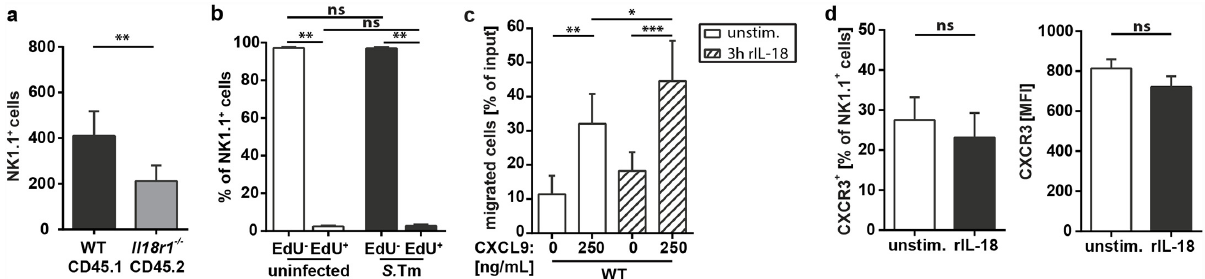
Fig 4. IL-18 enhances the migratory potential of NK cells. (a) Flow cytometric analysis of isolated cecal LP cells from 1:1 Il18r1 -/ — CD45.2:WT-CD45.1 mixed bone marrow chimeric mice, Sm-pretreated and infected orally with 5x10 7 CFU S .Tm for 12h (n = 9 per group). Single cells were gated on CD45 + CD3 - lymphocytes. Quantification of NK1.1 + cells from WT or Il18r1 -/- LP cells as distinguished by their congenic markers CD45.1 (WT) and CD45.2 ( Il18r1 -/- ). (b) Assessment of in vivo cell proliferation via EdU incorporation and flow cytometric analysis of isolated LP cells from C57BL/6 mice, either uninfected or infected orally with 5x10 7 CFU S .Tm for 12h (n = 5 – 6 per group). Quantification of EdU incorporation in CD3 - NK1.1 + cells. (c) 2D Transwell migration assay of splenic NK cells isolated by MACS and stimulated for 3h in presence or absence of 100ng/mL rIL-18. Migration was analyzed towards the indicated concentrations of CXCL9 (n = 4 per group). (d) Flow cytometric analysis of CXCR3 surface expression on splenic NK cells, stimulated for 3h in presence or absence of 100ng/mL rIL-18 (n = 4 per group). Data represent the mean ± SD and statistical analyses were performed using the Mann-Whitney-U test or ordinary one-way ANOVA (ns = not significant, * = p < 0.05; ** = p < 0.01; *** = p < 0.001).